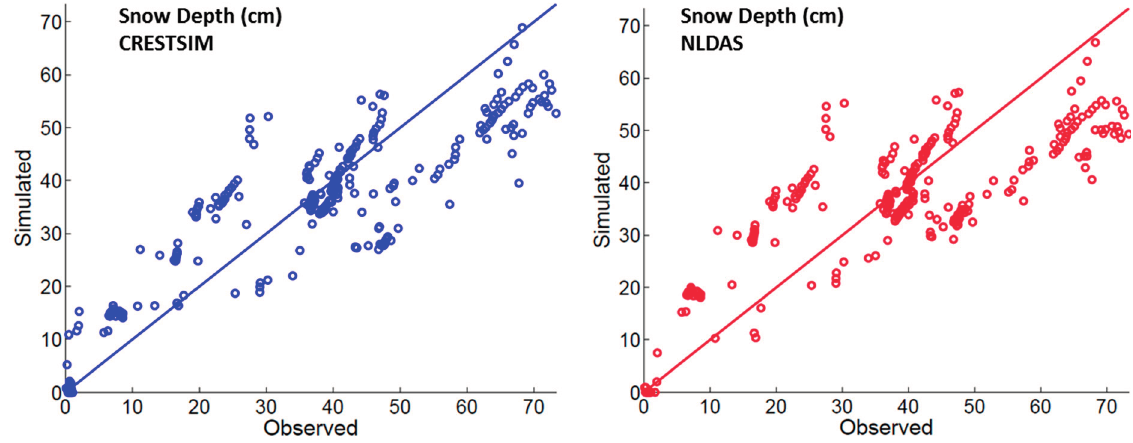
Figure 4. Time series for 2011–2012 winter snow depth (cm). Legend: snow depth observations (Observed), NLDAS meteorological data simulation (NLDAS), and CREST-SAFE meteorological data simulation (CRESTSIM).